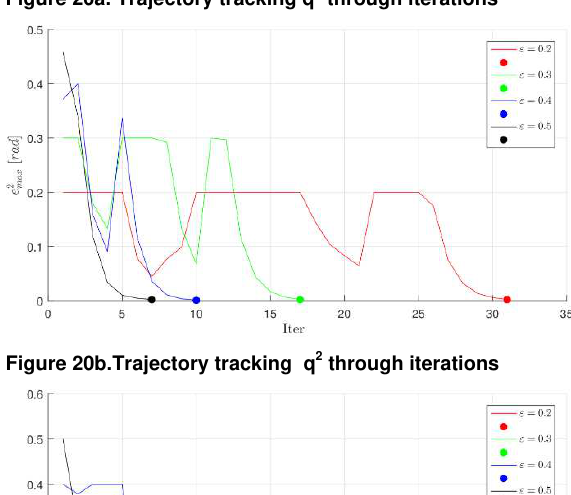
Figure 20a. Trajectory tracking q 1 through iterations